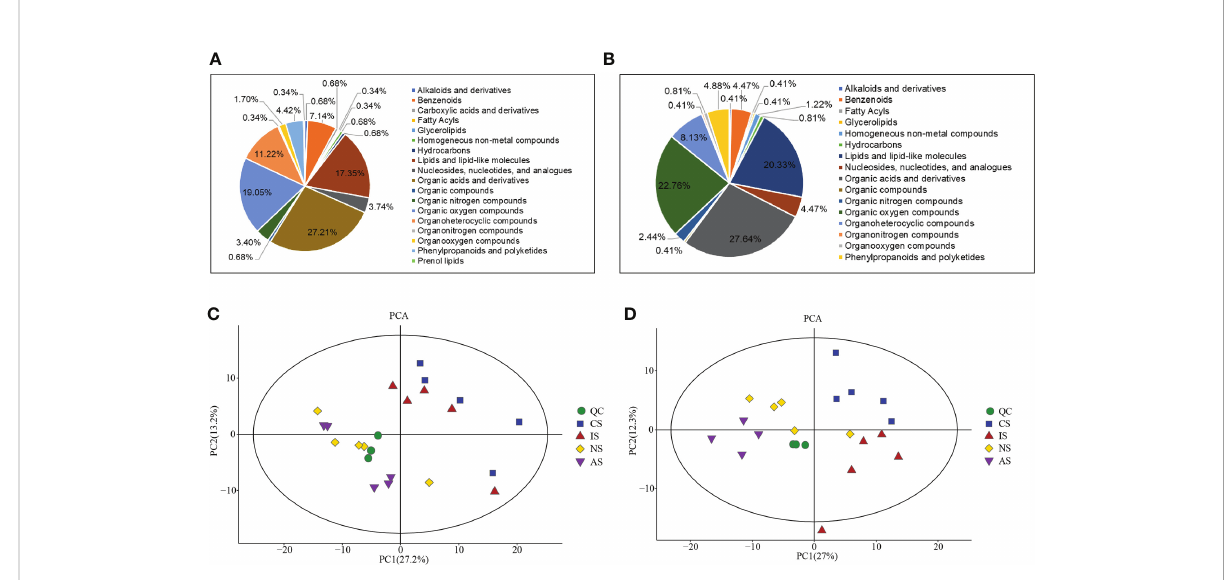
FIGURE 1 Data overview. Super class classi fi cation of total metabolites in gill (A) and hemolymph (B) ; PCA score plot of metabolites in gill (C) and hemolymph (D)